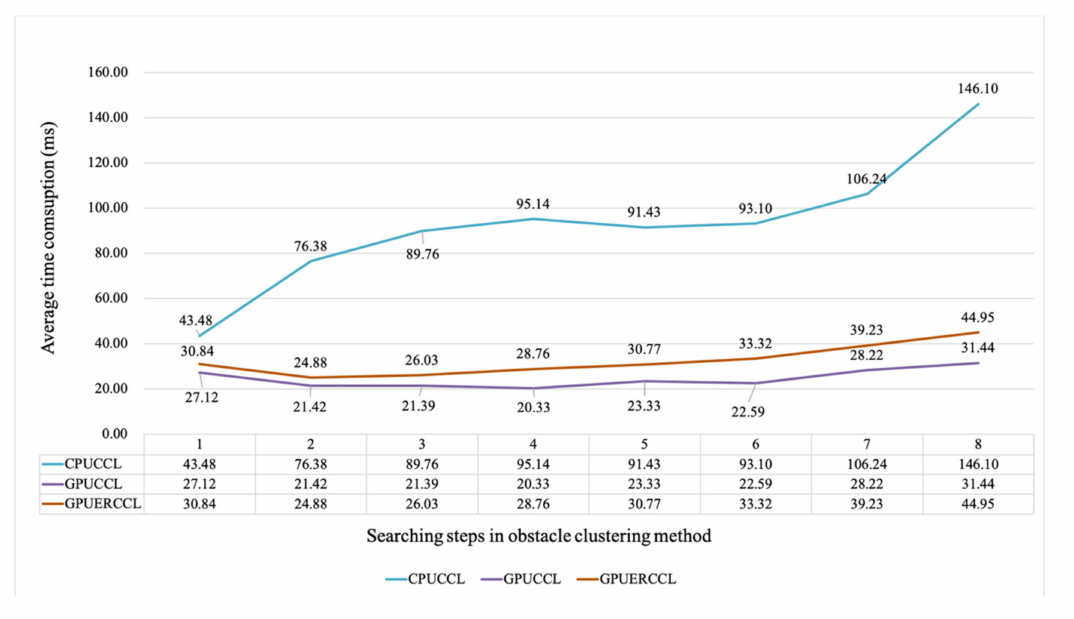
Figure 7. Speed performance with di ff erent numbers of search ranges.